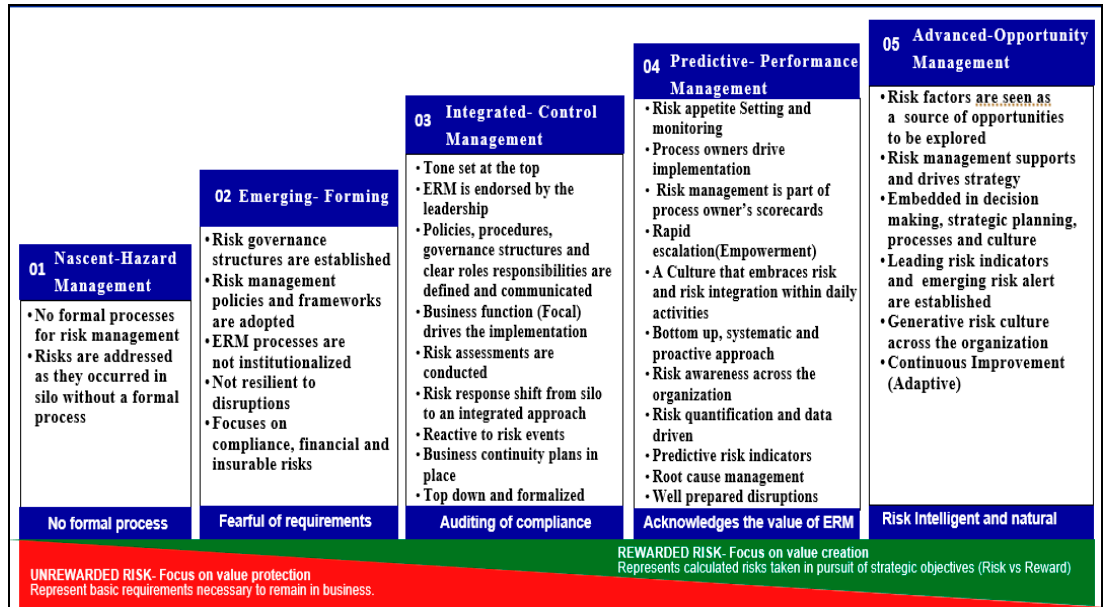
Figure 1. Risk governance maturity requirements per level (Association for Federal Enterprise Risk Management (AFERMS) 2018).